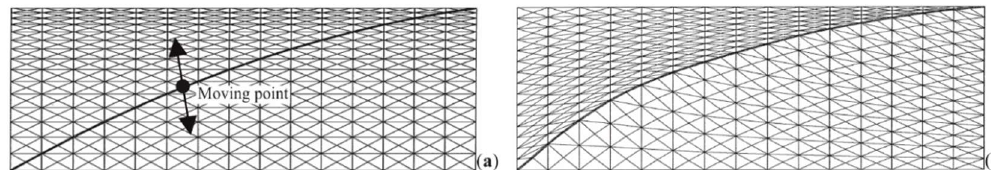
Figure 6. Initial ( a ), required ( b ) and final ( c ) relative magnetic flux density B y / B max in the air gap above the SM pole from Figure 5.